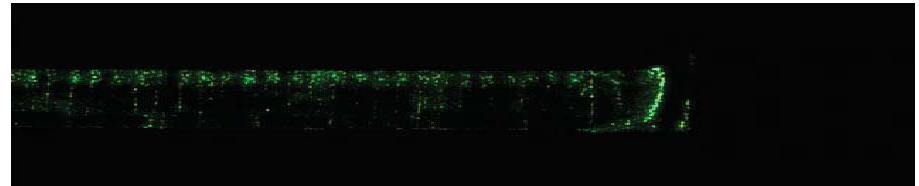
Figure 17. Schematic of the wavy pattern defect.